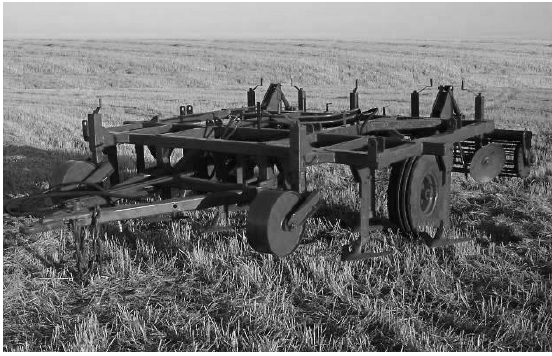
Figure 2. General view of the laboratory and field installation The laboratory and field installation had a working width of 3.9 m. It was equipped with 9 flat-cutting working bodies, five batteries of disk working bodies, and a double drum press roller. The working bodies used in the experimental studies are shown in Figure 3.